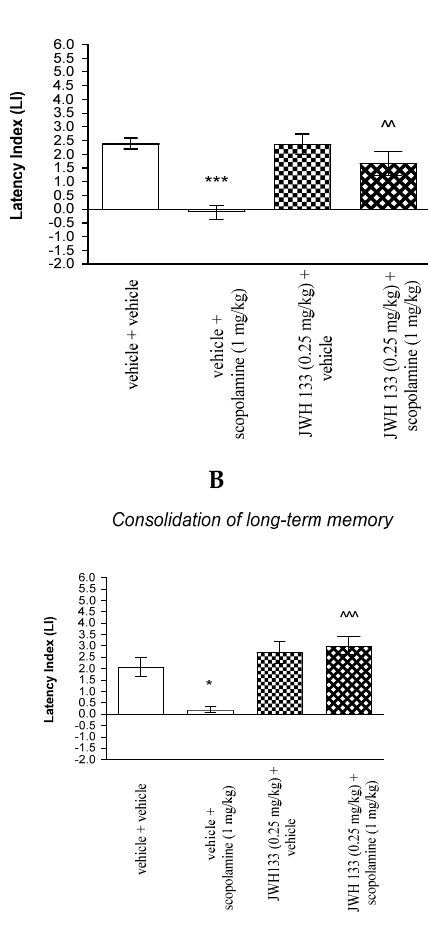
Figure 8. The influence of an acute co ‐ administration of CB2 ‐ Receptor agonist and effective (amnestic) dose of scopolamine on the cognition ‐ related responses expressed as latency index (LI) during the acquisition ( A ) and consolidation ( B ) memory using the PA test in mice. * p < 0.05 vs. vehicle/vehicle ‐ treated mice; *** p < 0.001 vs. vehicle/vehicle ‐ treated mice; ^^ p < 0.01 vs. vehicle/scopolamine(1 mg/kg) ‐ treated mice; ^^^ p < 0.001 vs. vehicle/scopolamine (1 mg/kg) ‐ treated mice.